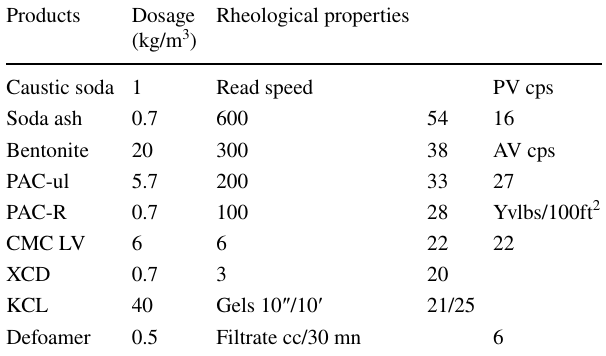
Table 1 Mud formulation for a density d =